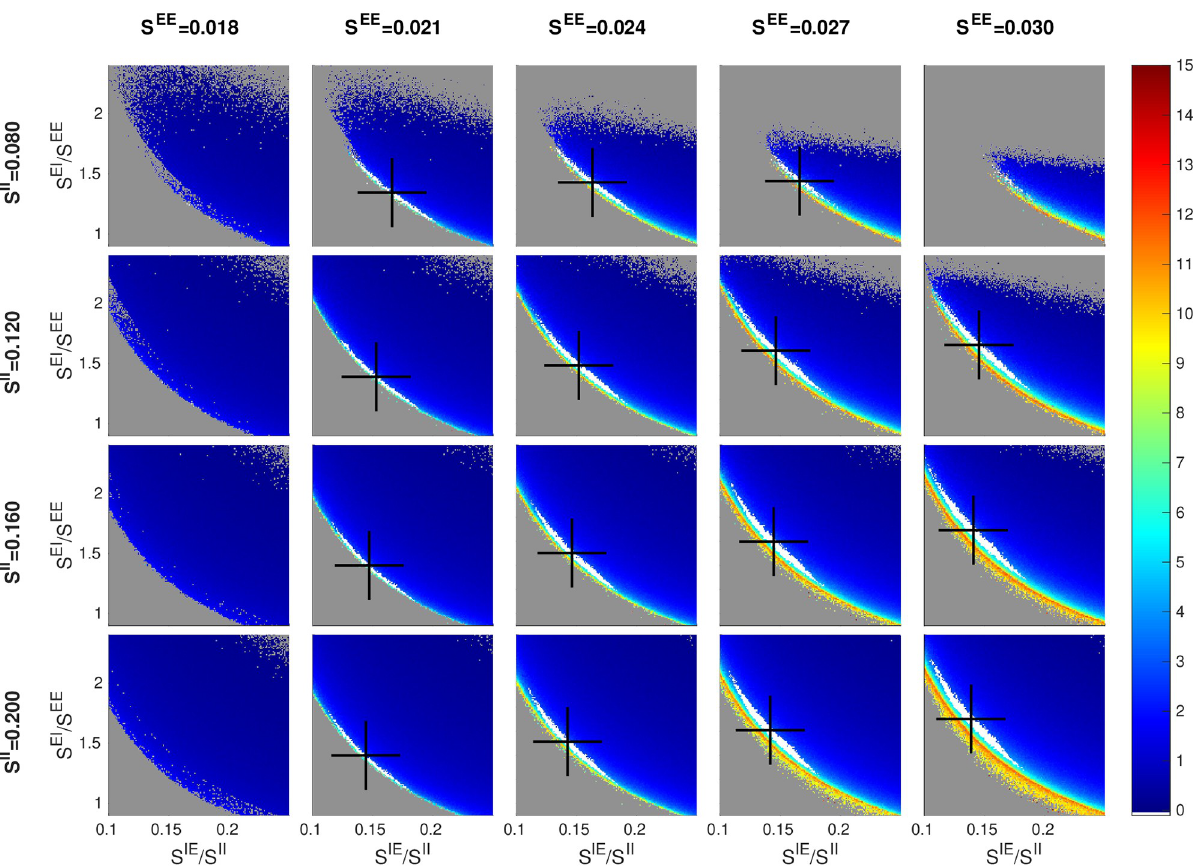
Fig 4. Dependence of firing rate and good area on S EE and S II . Smaller panels are as in Figs 2 and 3, with good areas (where visible) in white and black crosses denoting their centers of mass. The picture for S EE = 0.024 and S II = 0.120 (row 2, column 3) corresponds to the f